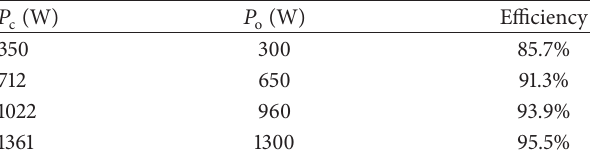
Table 2: Efficiency of power amplifier